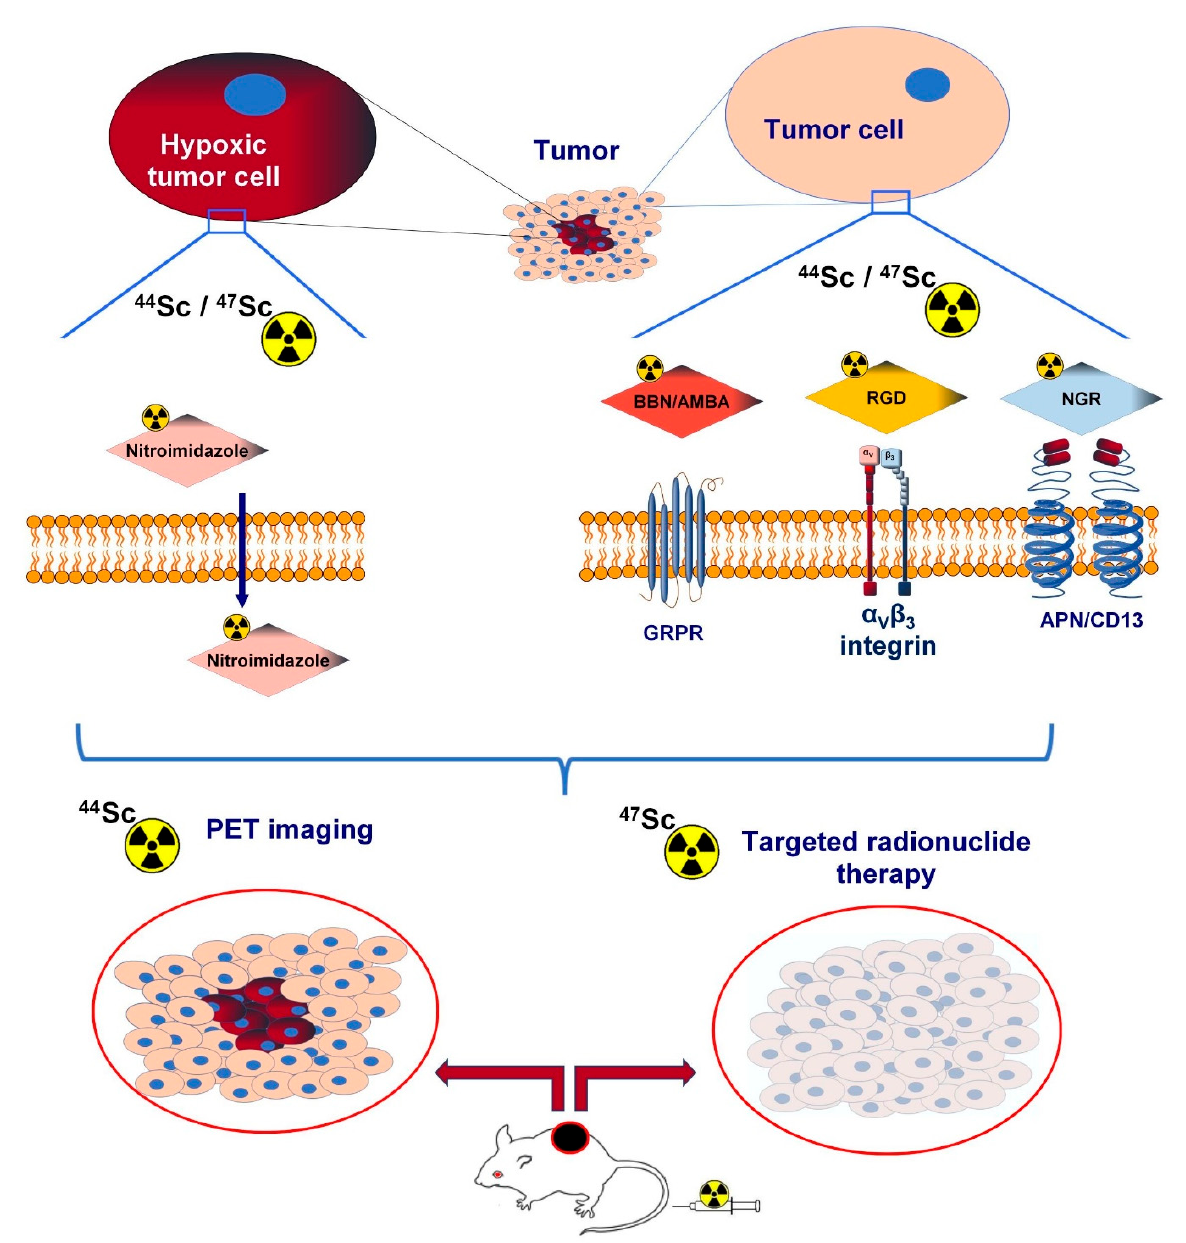
Figure 1. Sc 44 - and Sc 47 -labelled peptide-based radiopharmaceuticals in the molecular imaging and therapy of cancer-related angiogenesis. Table 1. Preclinical studies with 44 Sc-labelled PET radiotracers.